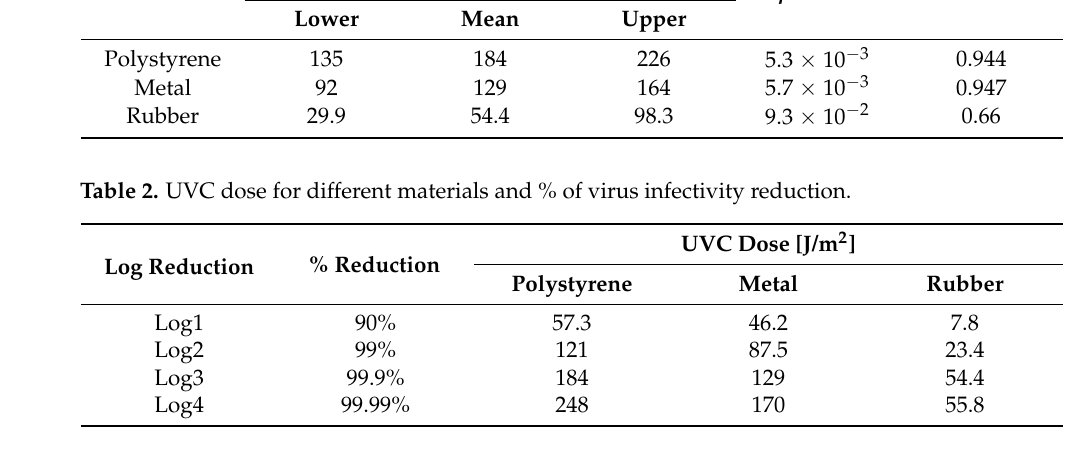
Table 3. Results of UVC susceptibility test on MDR bacteria performed in the ambulance.